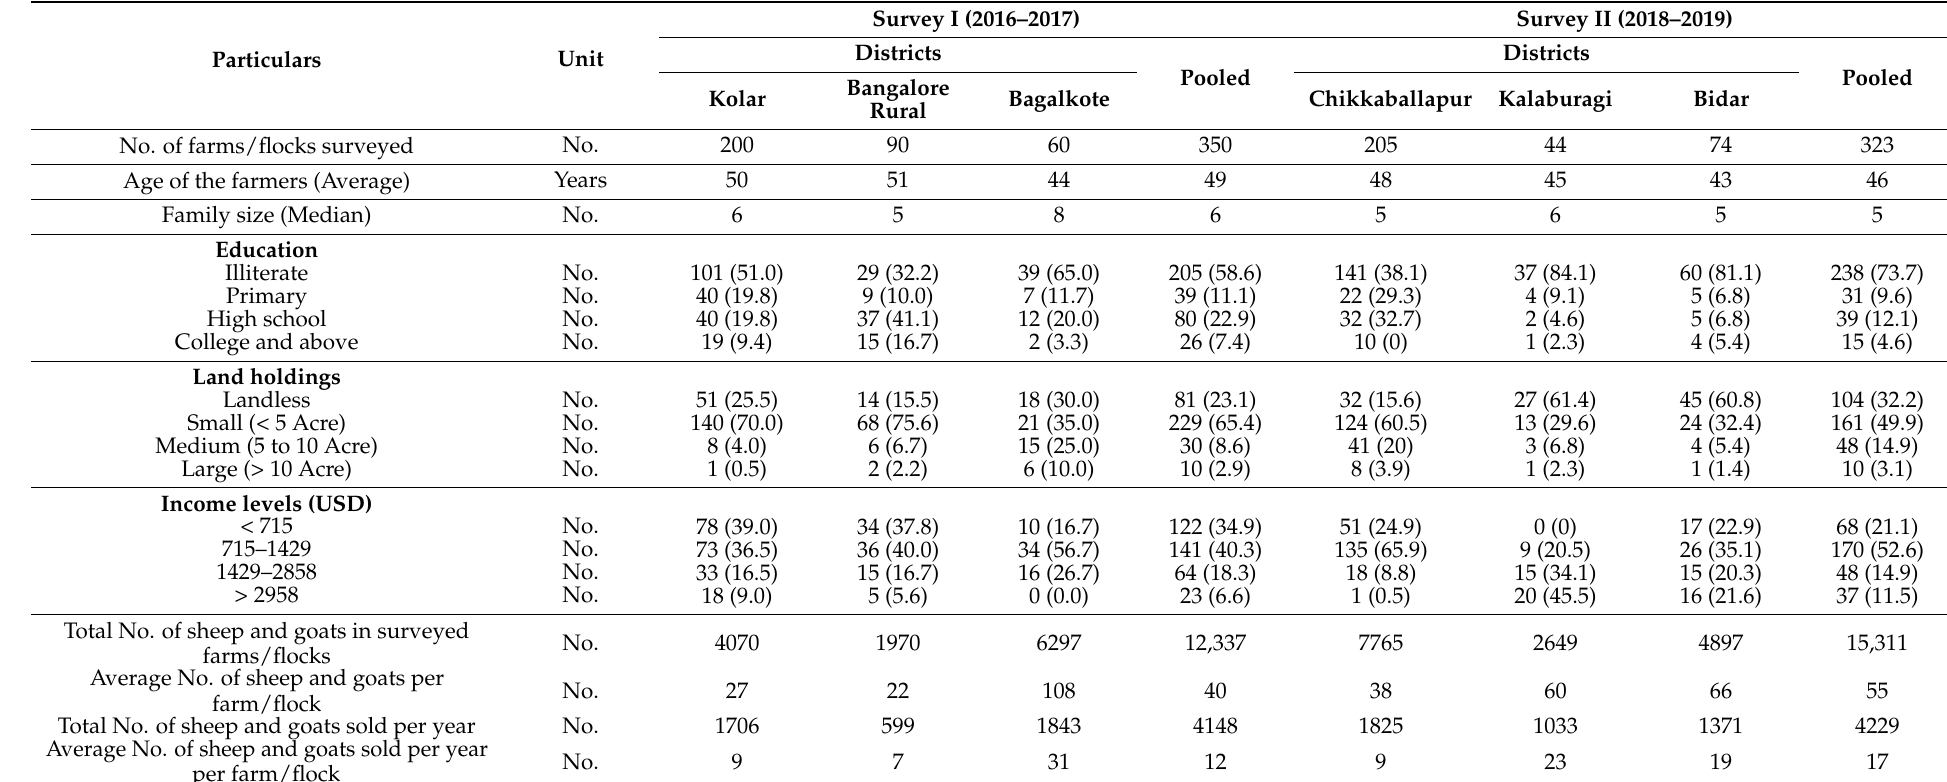
Table 1. General characteristics of sample farms in